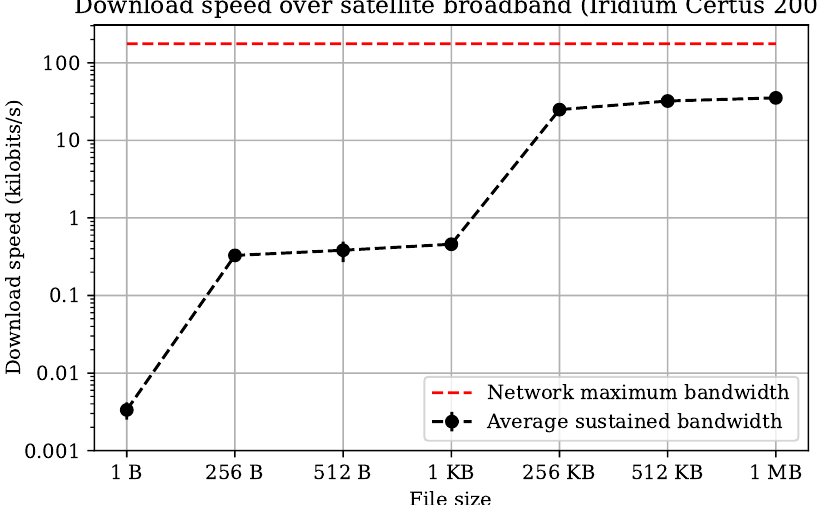
Figure 7. Observed download speed when downloading files of various sizes over a satellite broadband connection. The y -axis represents download speed, measured in kilobits per second, of the files represented on the x -axis. Additionally, the theoretical maximum network bandwidth as defined by the system provider [22,23] is